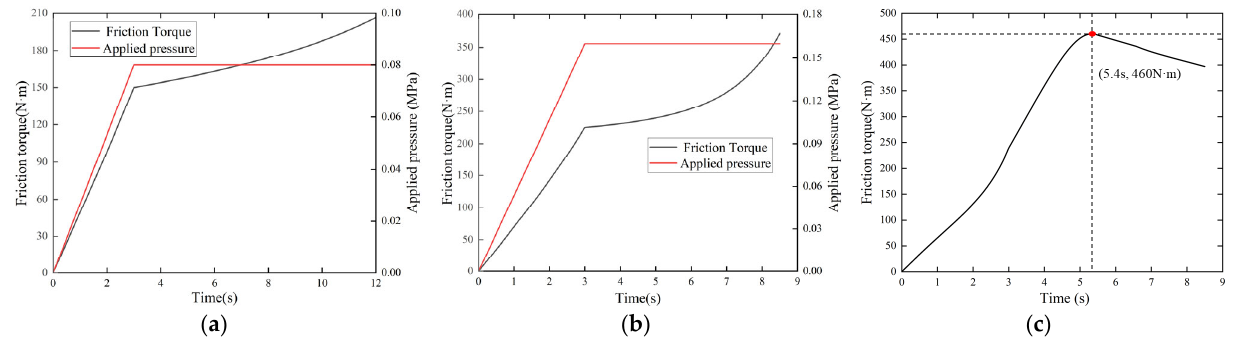
Figure 6. Simulation results for the friction torque. ( a ) Test 1 (UCS) ; ( b ) Test 5 (UCS); ( c ) Test 5